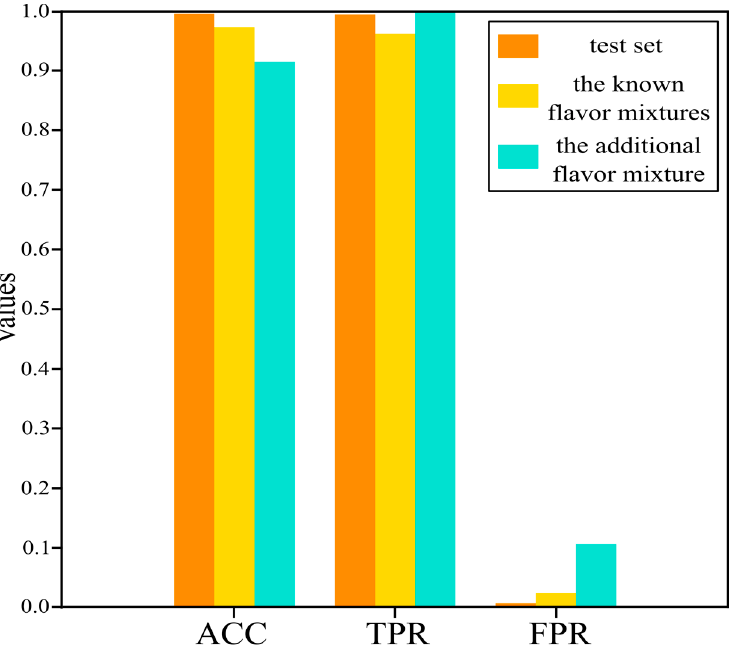
Figure 5. Performance evaluation on the test set and application of pSCNN on the known flavor mixtures and the additional flavor mixture.